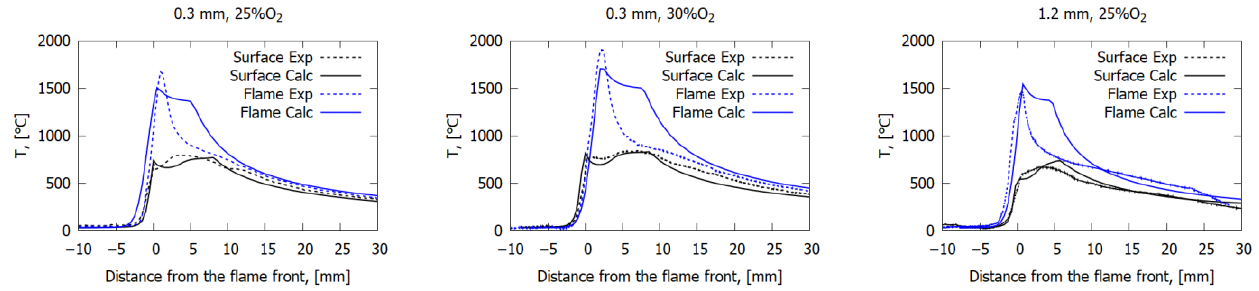
Figure 10. Temperature profiles in the flame (1.2 mm above the surface) and on the fiberglass plastic surface.